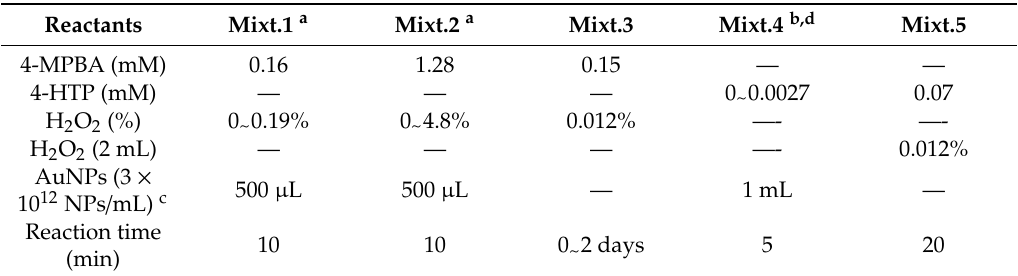
Table 1. Reaction conditions involved in the